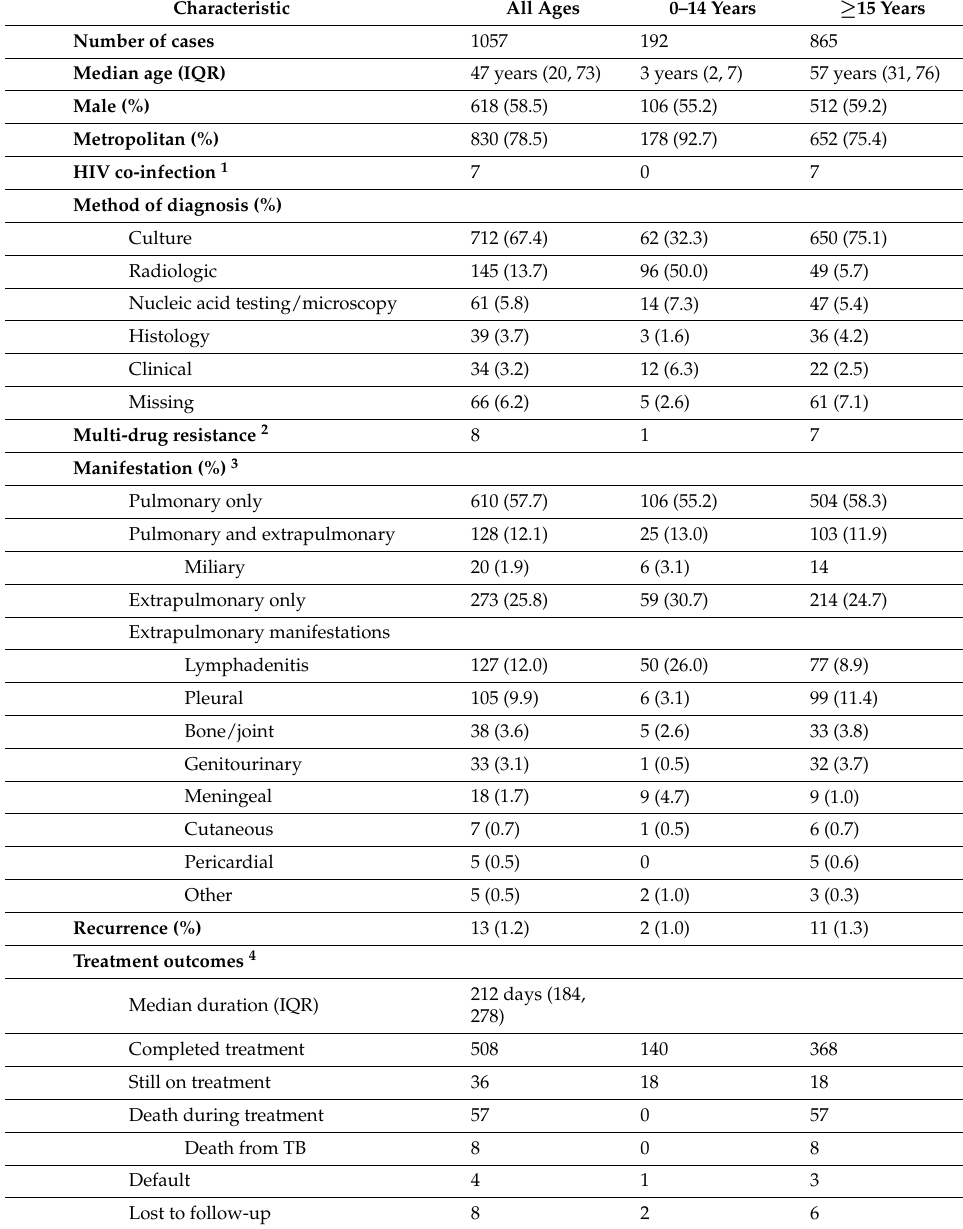
Table 1. Selected characteristics of tuberculosis (TB) cases in the Australian-born in Victoria between 1992 and